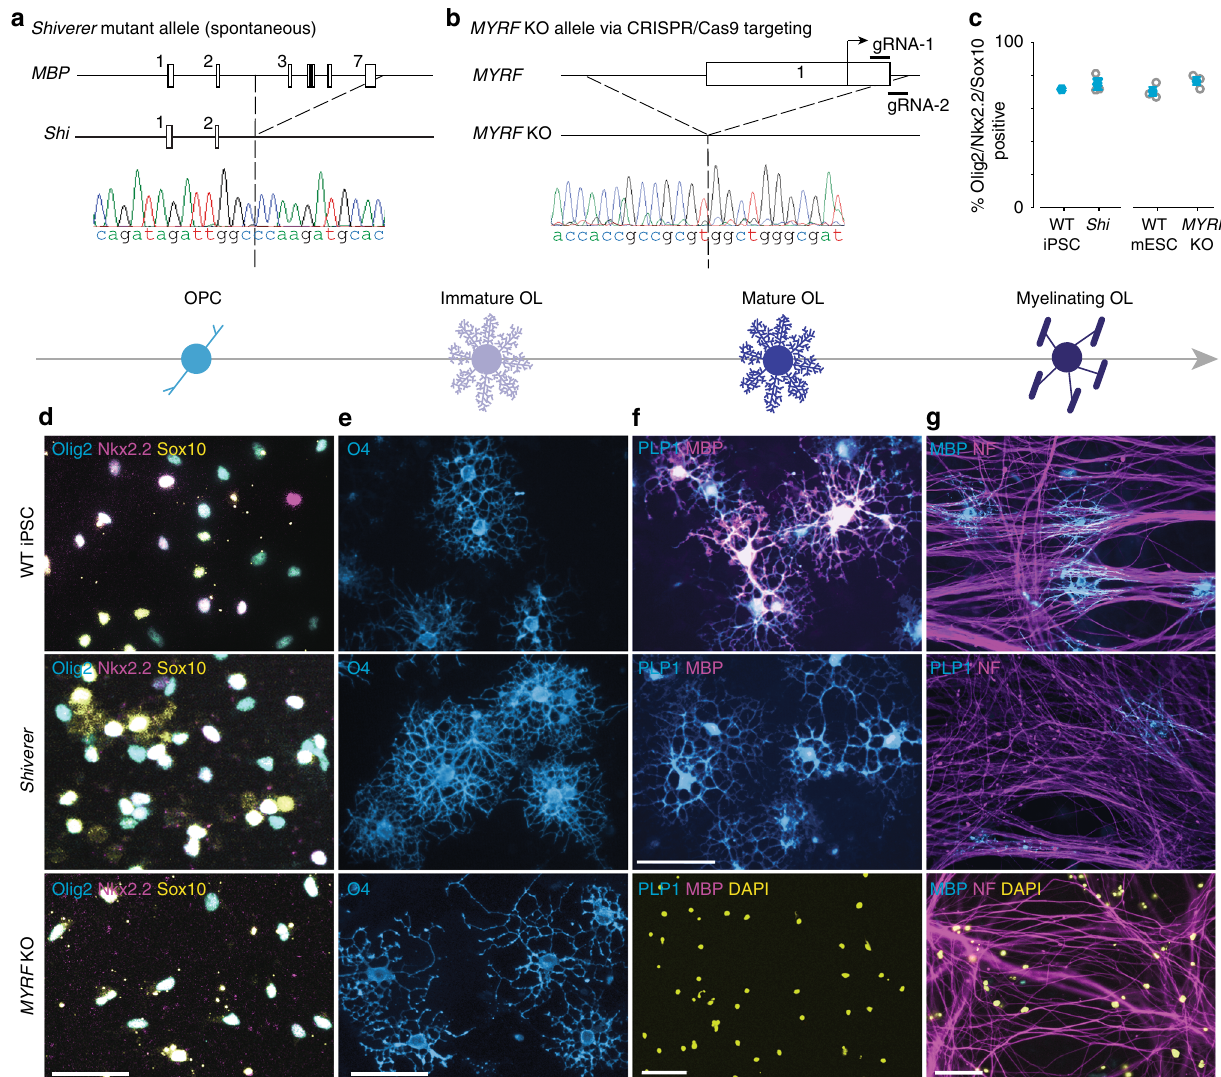
Fig. 2 Cellular pro fi ling of spontaneous and purposely generated mutant oligodendrocyte alleles. a Diagram indicating that shiverer mice harbor a ~20- kilobase (kb) homozygous deletion encompassing exons 2 – 7 of the MBP gene. A Sanger sequencing trace shows the breakpoint of the shiverer deletion. b Diagram indicating the location of the two gRNAs designed to target MYRF . A Sanger sequencing trace shows the location of the homozygous deletion of exon 1. c Quanti fi cation of transcription factors Olig2, Nkx2.2, and Sox10 at passage 3 of the differentiation protocol. n = 3 shiverer cell lines; n = 3 replicate wells per cell line; >179,500 cells scored per well. n = 3 MYRF KO and wild-type (WT) mESC replicate wells per cell line; >700 cells scored per well. Data are represented as means ± SEM. d Fluorescent images of WT iPSC, shiverer , and MYRF KO OPCs expressing canonical OPC markers Olig2, Nkx2.2, and Sox10. Scale bar, 50 µ m. e Cell surface immunostaining of the immature oligodendrocyte marker O4, after treatment with T3, of WT iPSC, shiverer , and MYRF KO OPCs. Scale bar, 50 µ m. f Representative images of differentiated OPCs immunostained for mature oligodendrocyte markers MBP and PLP1, 72 h post treatment with T3 of WT iPSC, shiverer , and MYRF KO OPCs. Scale bar, 50 µ m. g Representative images of OPC/DRG co-cultures stained for MBP and neuro fi lament (NF) at day 10 from WT iPSC, shiverer , and MYRF KO OPCs stained for PLP1 or MBP after being co-cultured for 10 days with NF + embryonic rat DRGs. Scale bar, 50 µ